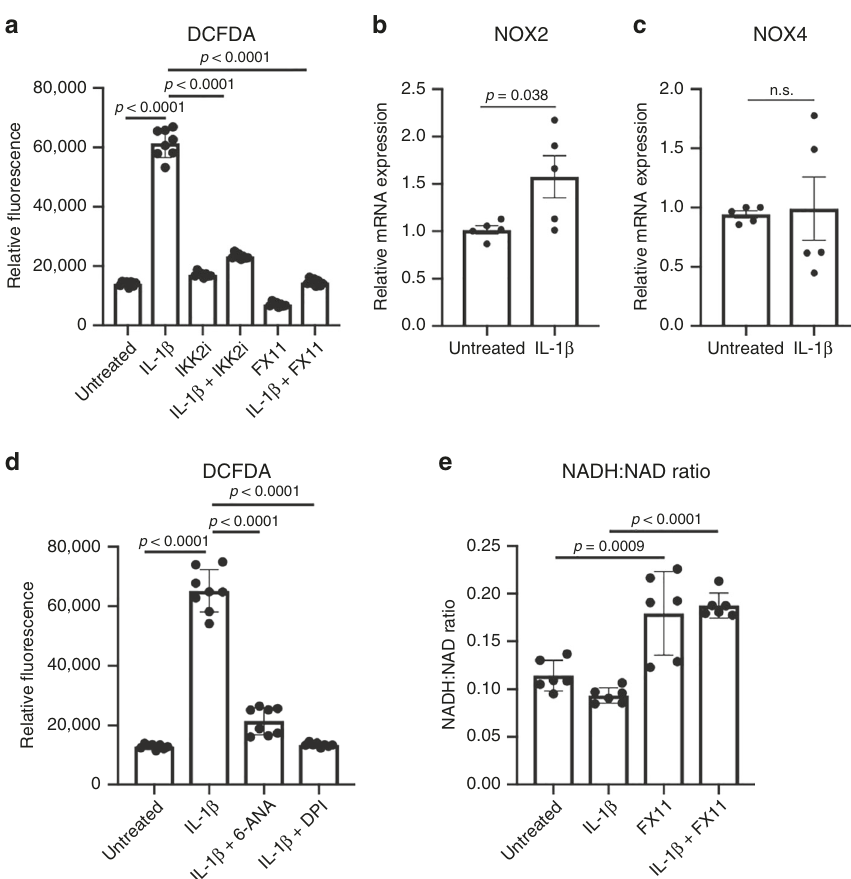
Fig. 5 LDHA interaction with NADH propagates ROS. a Primary chondrocytes were treated with IL-1 β (10 ng/mL) in the presence or absence of IKK2i (10 μ M) or FX11 (40 μ M) for 24 h. DCFDA assay was performed and fl uorescence was measured by microplate reader to determine intracellular ROS levels, displaying reduction in ROS levels. Results are representative of one experiment out of three, with bars representing mean ± S.D. for n = 8 wells. b , c Primary chondrocytes were treated with IL-1 β (10 ng/mL) for 24h. qPCR was performed to measure gene expression of NOX2 and NOX4. Bars represent mean ± S.E.M. for n = 5 independent experiments. d Primary chondrocytes were treated with IL-1 β (10 ng/mL) in the presence or absence of 6-ANA (100 μ M) or DPI (1 μ M) for 24 h. DCFDA assay was performed and fl uorescence was measured by microplate reader to determine intracellular ROS levels, displaying reduction in ROS levels. Results are representative of one of three independent experiments, with bars representing mean ± S.D. for n = 8 wells. e Chondrocytes were treated with IL-1 β (10 ng/mL) for 36 h in the presence of absence of FX11 (40 μ M). NAD + and NADH levels were measured in chondrocytes to calculate the NADH:NAD + ratio in biological replicates. Data are pooled from three experiments for n = 6 biological replicates, with error bars representing mean ± S.D. a , d , e One-way ANOVA was performed followed by Tukey ’ s multiple comparison ’ s test. b , c Two-tailed student ’ s t- test was performed. p -values displayed in fi